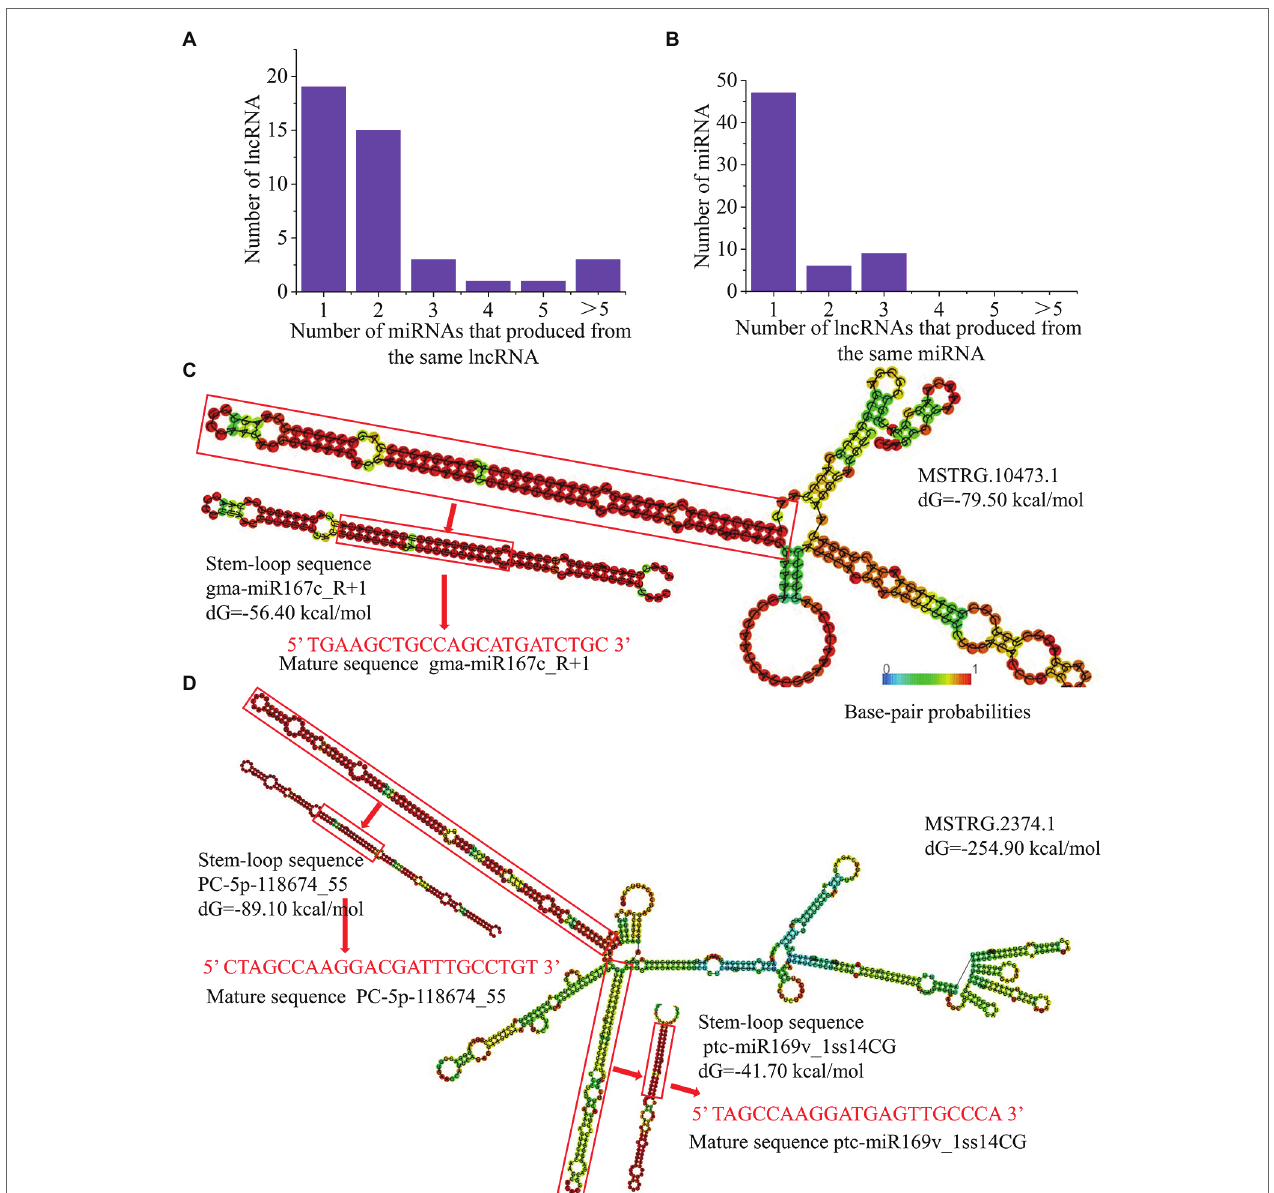
FIGURE 5 | LncRNAs as precursors of miRNAs in P. x canescens. (A) , Number of miRNAs produced by lncRNAs. (B) , Number of lncRNAs that produce the same miRNA. (C) , Predicted secondary structure of MSTRG.10473.1, which contains one precursor sequence of gma-miR167c R+1. (D) , Predicted secondary structure of MSTRG.2374.1, which contains two precursors, namely, PC-Sp-118674_55 and ptcmiR169v lss14CG. The secondary structures were predicted using RNAfold. The color scale indicates high (red) to low (blue) probabilities of base